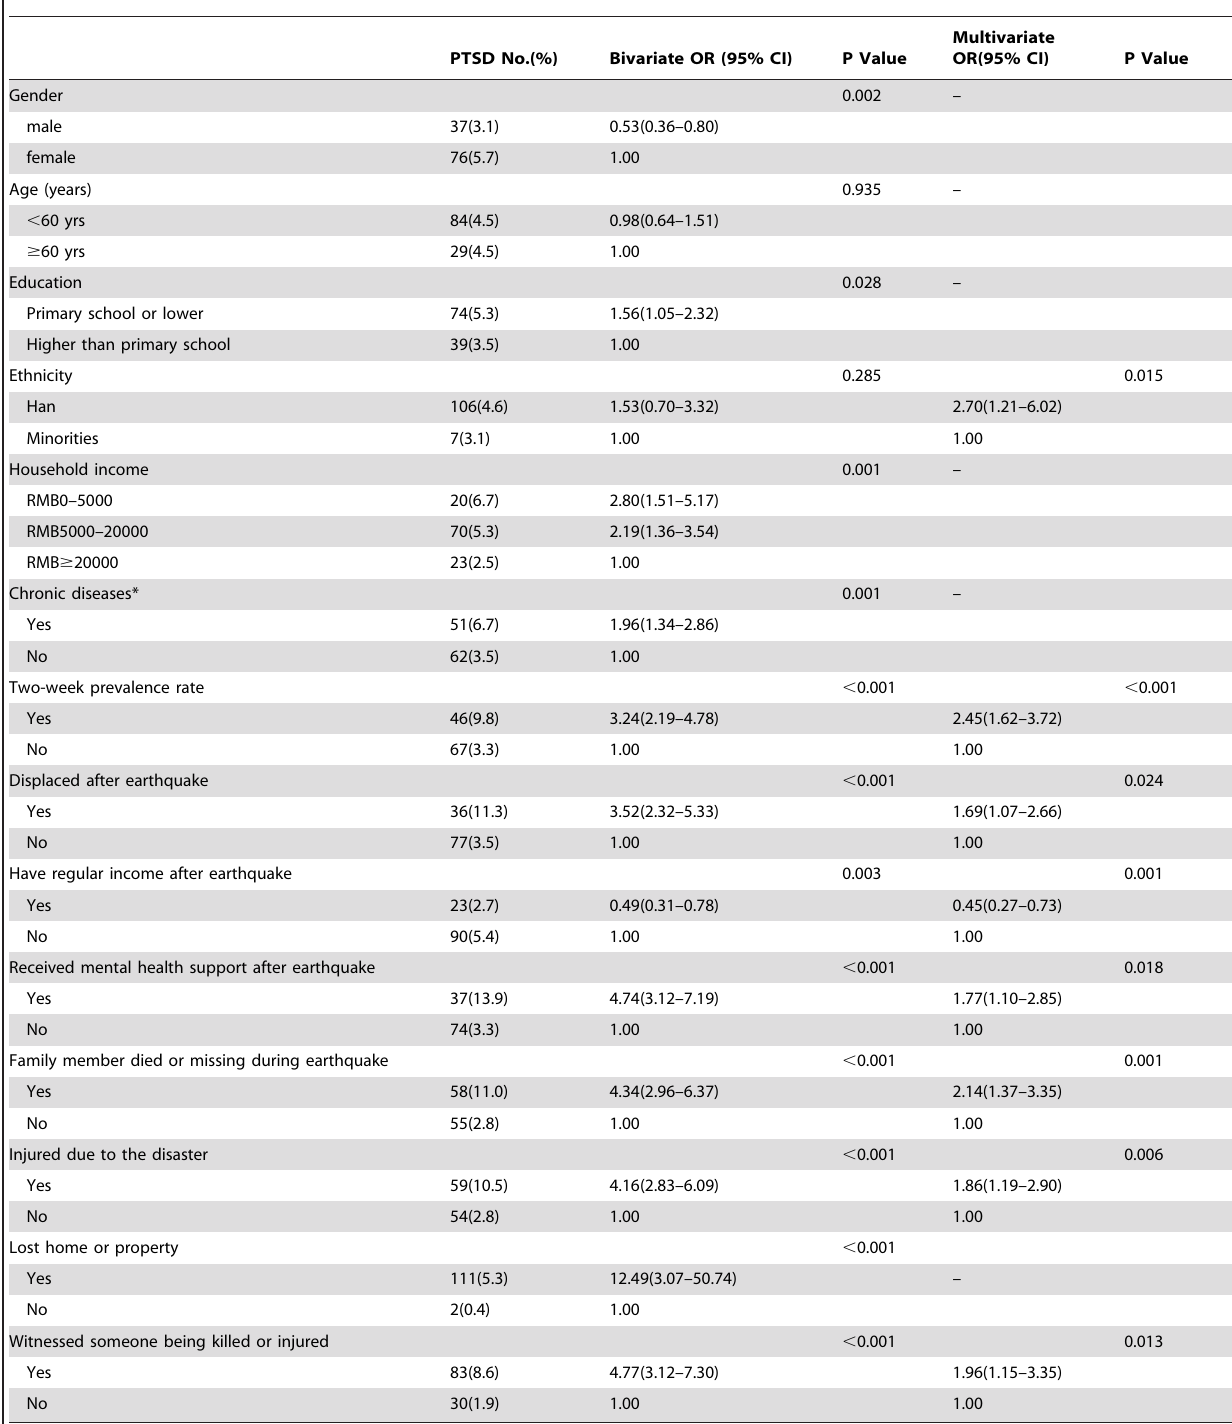
Table 3. Risk factors of PTSD symptoms by logistic